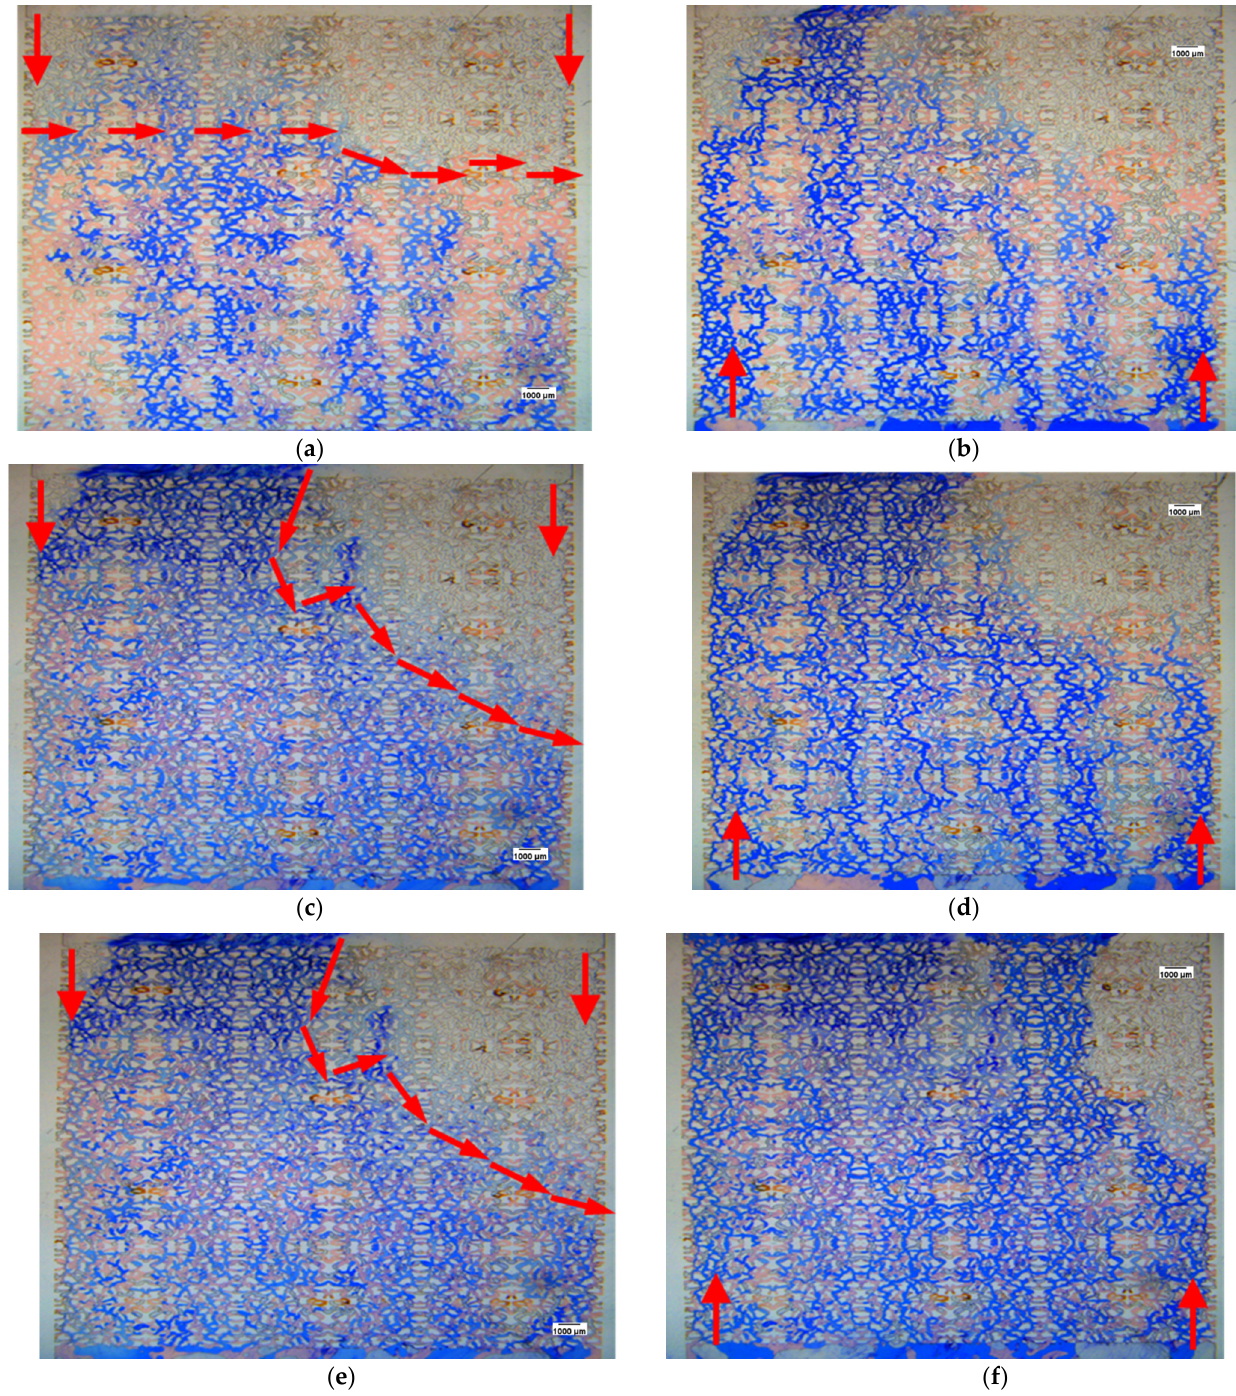
Figure 14. The process diagram of the homogeneous model gel-emulsifier compound water shutoff process. ( a ) The first gel injection, ( b ) the second water invasion, ( c ) the first emulsifier injection, ( d ) the third water invasion, ( e ) the second gel injection, ( f ) the fourth water invasion.